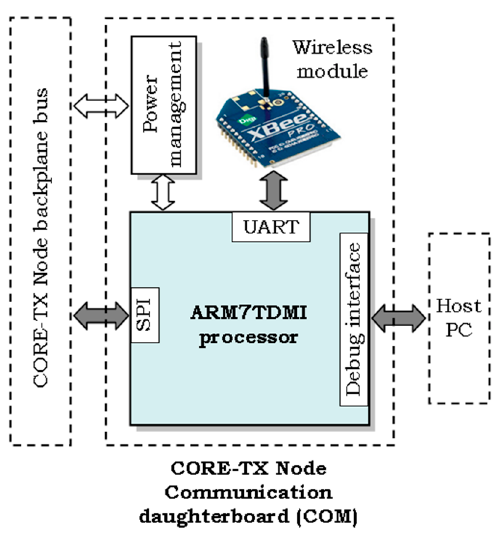
Figure 10. Block diagram of the CORE-TX node Communication board. Table 2. Main system and task configuration parameters of the CORE-TX based experimental setup.